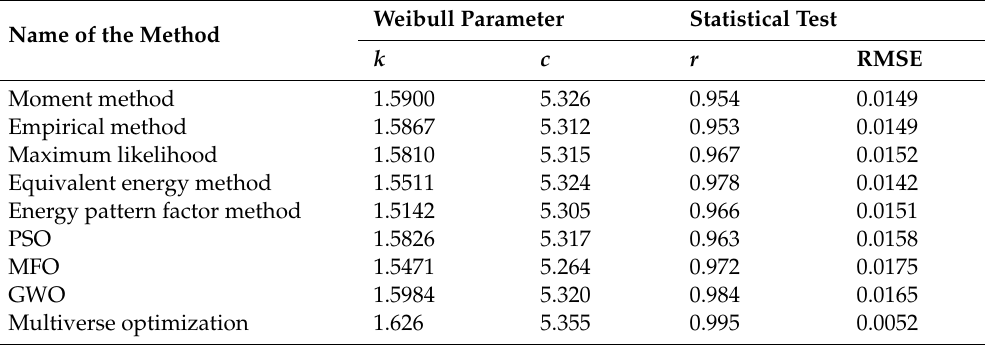
Table 1. Comparison of di ff erent numerical methods with multiverse